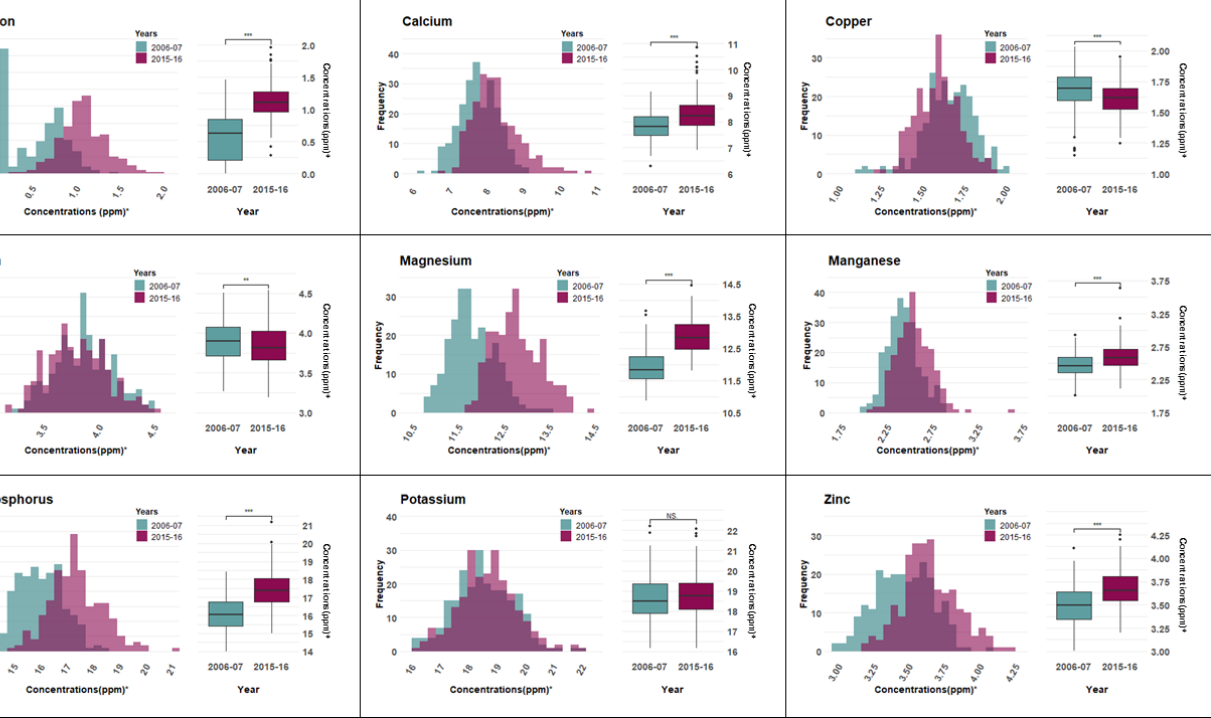
Figure 1. Histograms and boxplots demonstrating and comparing the distribution of mineral element concentrations (ppm) in 232 accessions of the WBDC. ** p -value < 0.01, *** p value < 0.001, NS = no significant